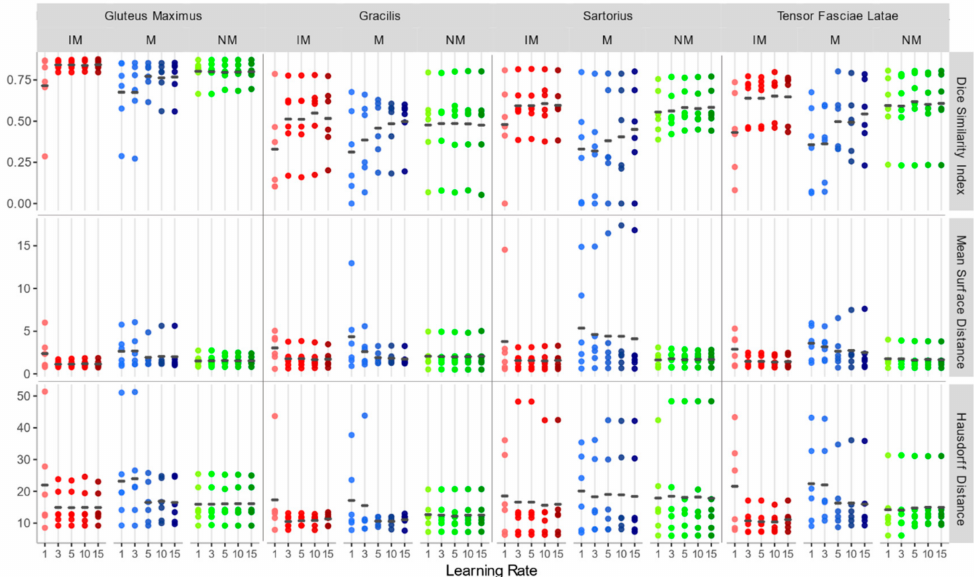
Figure 6. DSI, MSD (mm), and HD (mm) for each individual considered muscle (Gluteus Maximus, Gracilis, Sartorius, Tensor Fasciae Latae) for rigid registration